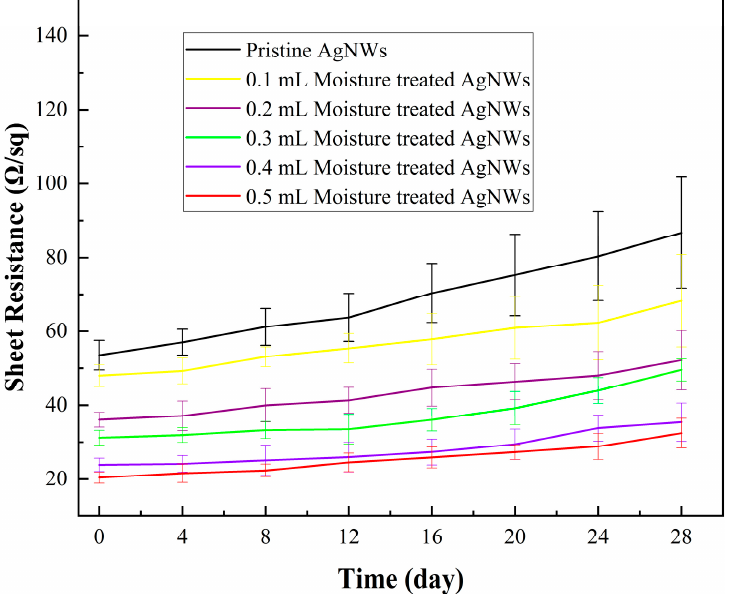
Figure 9. Test results of electrical stability in air environment of AgNWss-TCF before and after moisture treatment.